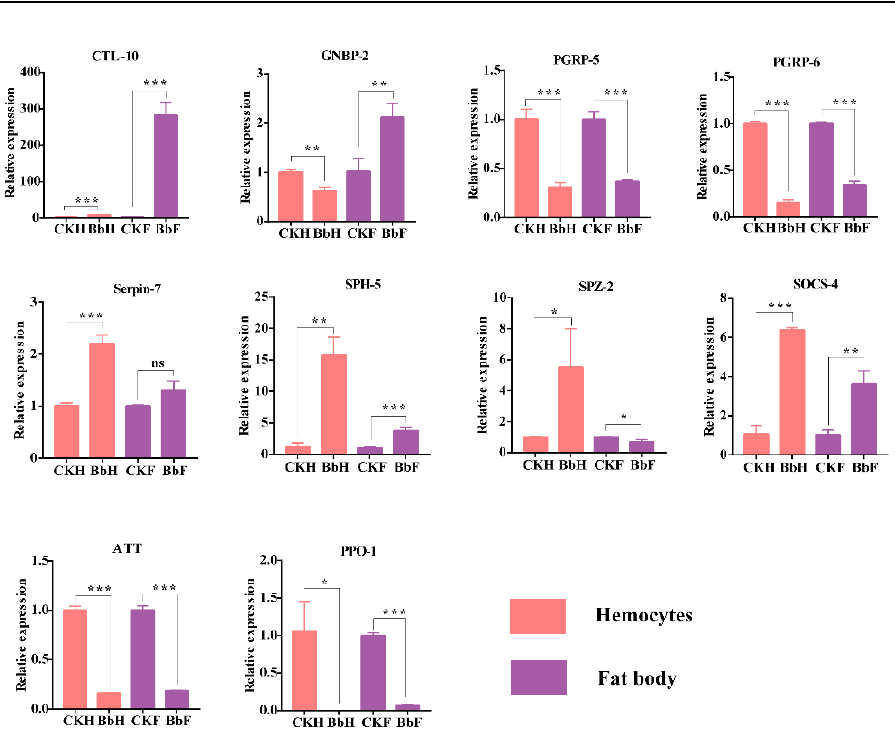
Figure 9. Quantitative real-time PCR analysis of the E. oblique immunity-related gene expression in hemocytes and fat body after B. bassiana (48 h) injection. β -actin was used as an internal reference gene. The data is represented as the mean ± S.D. ( n = 3). * p < 0.05; ** p < 0.01. *** p < 0.001. ns: no significance.